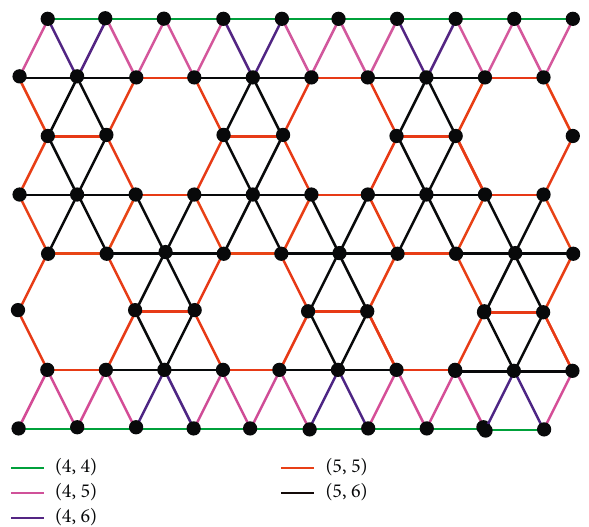
Figure 4: The edge partitions of BA ( X )[ 8 , 6 ] with respect to degree of end